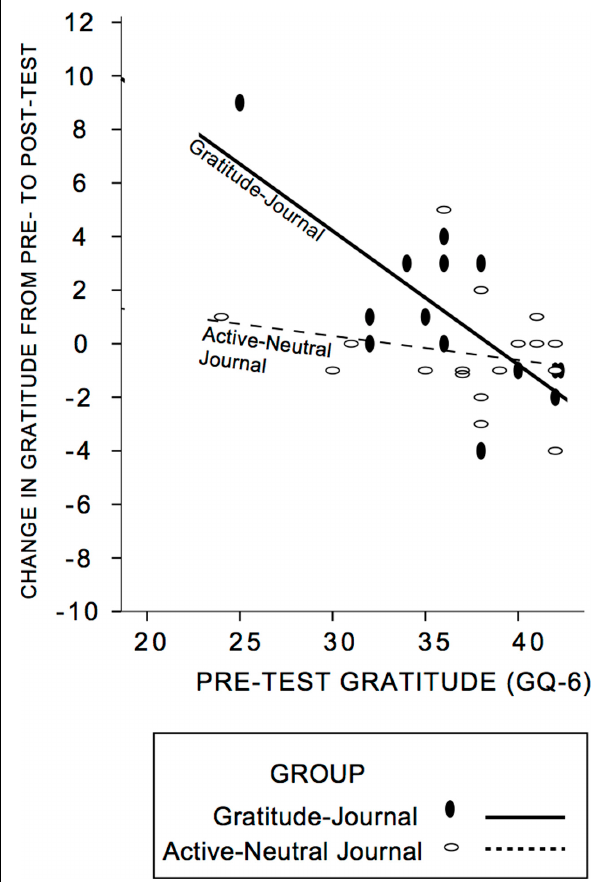
FIGURE 3 | Group assignment moderated the influence of pre-test gratitude on post-test gratitude. Participants lower in pre-test gratitude who were randomly assigned to the Gratitude-Journal condition showed greater gratitude change at post-test. Solid lines and circles represent the gratitude-journal group and dashed lines and open circles represent the active-neutral control group. Supplementary Figure S2, demonstrates that estimates are not driven by the extreme